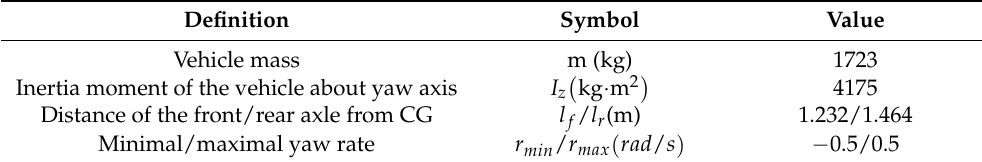
Table 2. Symbol and definition of parameters. Figure 9 . Co-simulation block diagram. Figure 9. Co-simulation block diagram. Table 1. Symbol and definition of parameters.